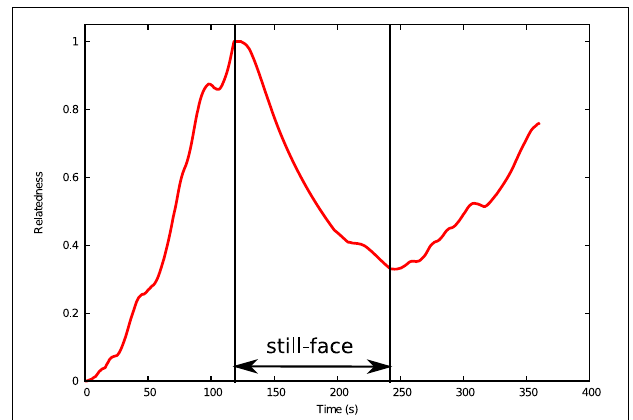
Table 3 | Parameters of action motivation.